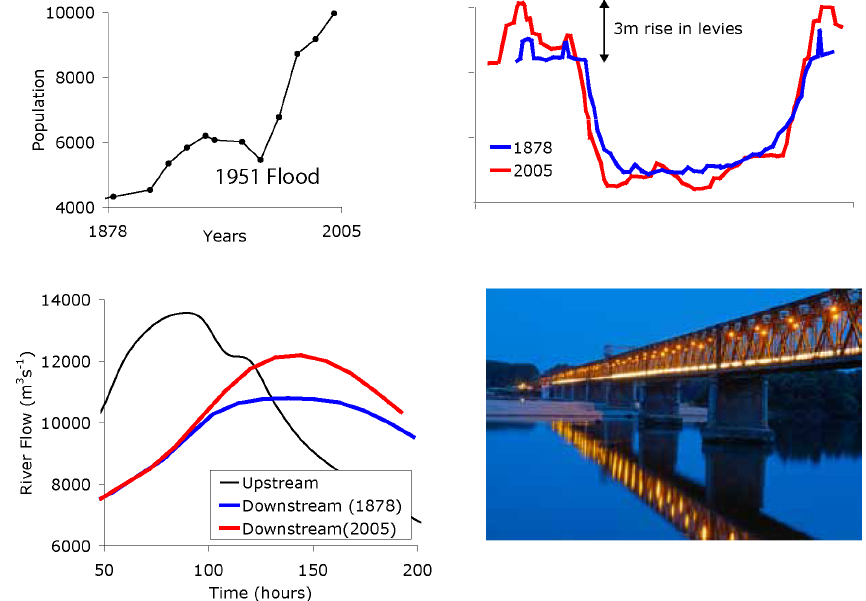
Fig. 4. A simple illustration of hydrologic reconstruction from this issue (Di Baldassarre et al., 2013): as societies develop in floodplains they modify the floodplain to alter the risk of flooding. In doing so, however, flow behavior within the floodplains change, altering the severity of specific events. Data shown are for the Pontelagoscuro region on the Po River,